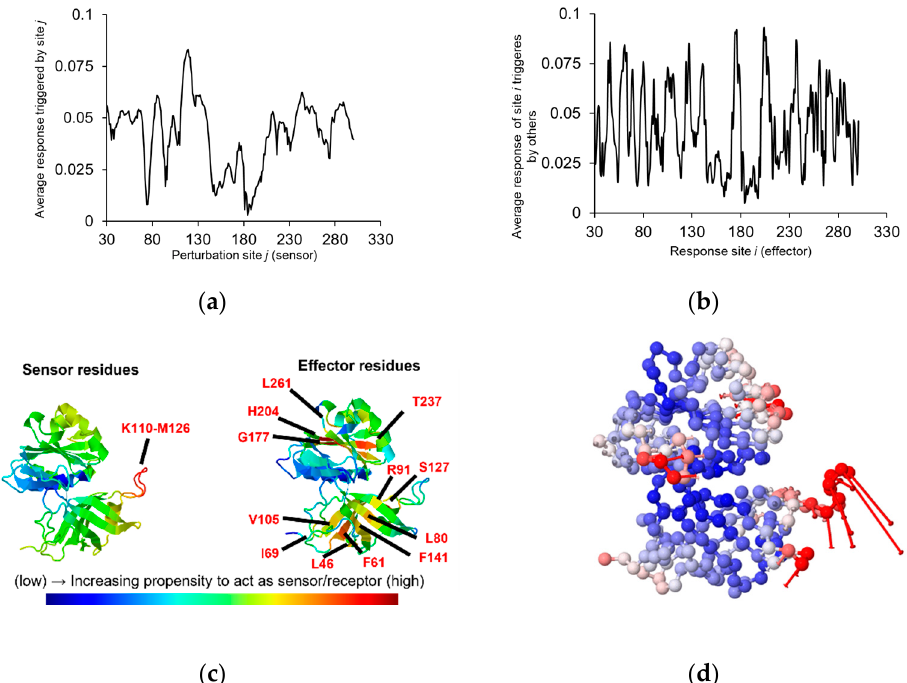
Figure 4. High sensor/effector residues of C b 5 R and molecular motions based on compiled information obtained through analysis of the intrinsic dynamics. Correlation between the average response by a site triggered with a perturbation in the C b 5 R sequence acting as a sensor is shown in panel ( a ). Correlation between the average response of a site triggered by others with a responsive site in the C b 5 R sequence acting as an effector is shown in panel ( b ). Representation of the C b 5 R areas, which have an increasing propensity to act as sensor/receptor and label residues located in hot spotted areas, is shown in panel ( c ). Animation obtained with the second-highest ranked model based on the previously analyzed information, where the areas are color coded based on the size of motions where the color indicate the type of fluctuations in a red-white-blue scale (red colors correspond to large fluctuations and blue colors to small fluctuations.), is shown in panel ( d ). Also in this panel, vectors (red lines) represent the direction of motion of each residue.